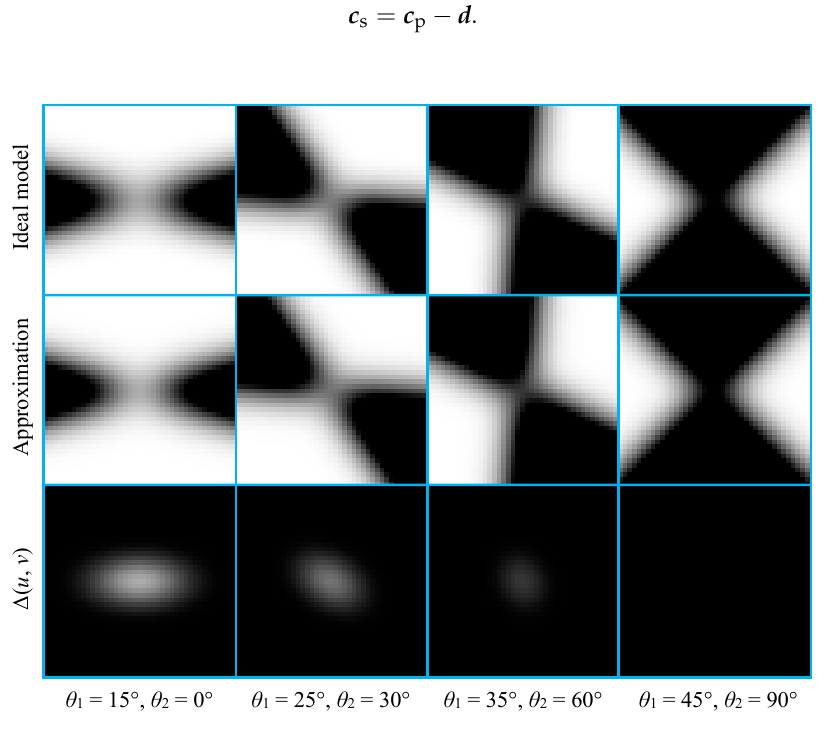
Figure 2. Gray images simulated by the ideal model, approximated model, and Δ ( u , v ), with different values of θ 1 and θ 2 . The image size is 41 × 41 pixels, σ = 4.